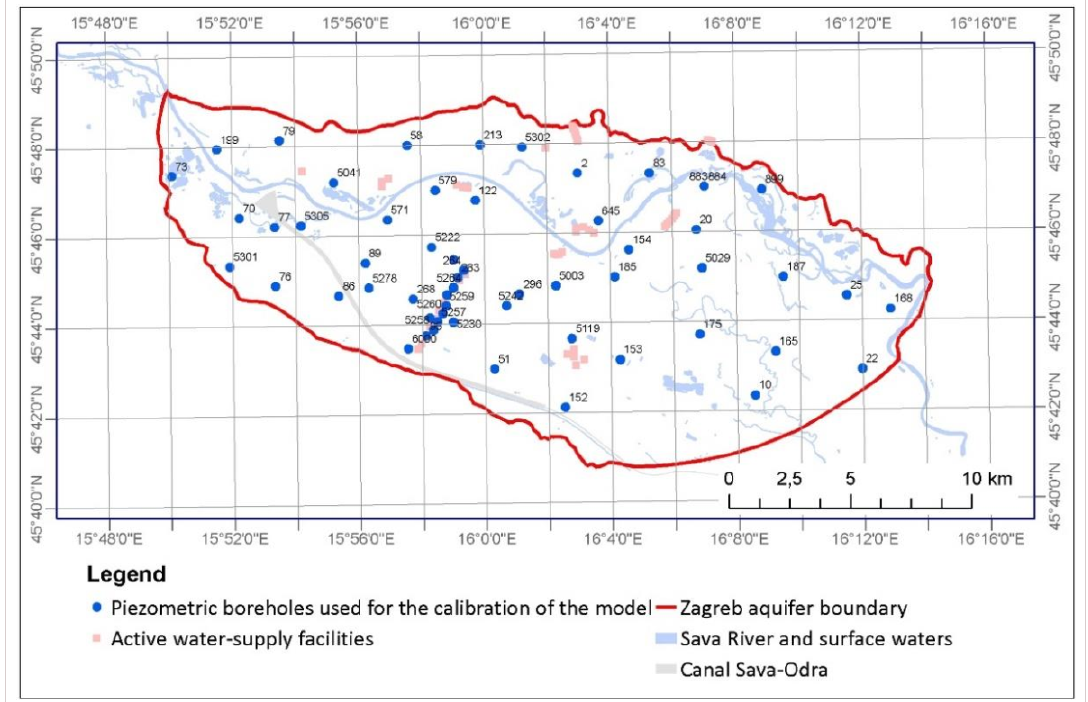
Figure 7. Spatial distribution of piezometric wells used for model calibration and